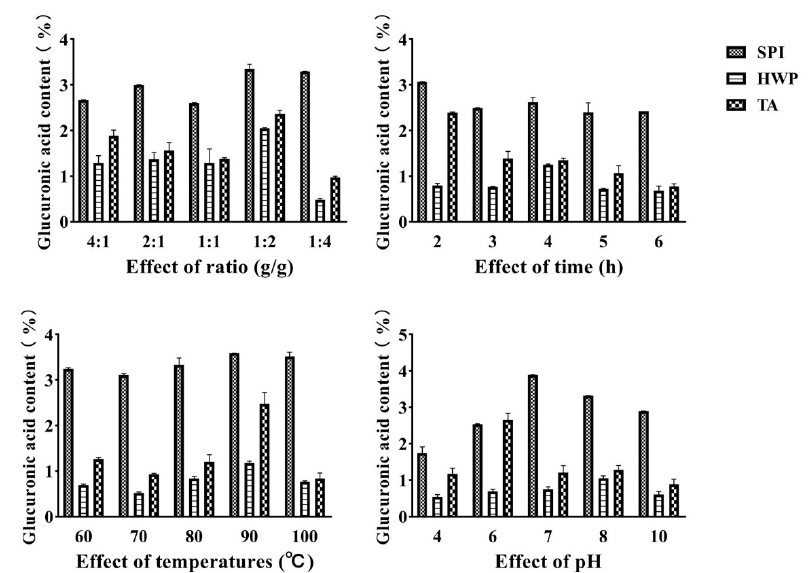
Figure 5. The uronic acid content of the complex under di ff erent treatment conditions.